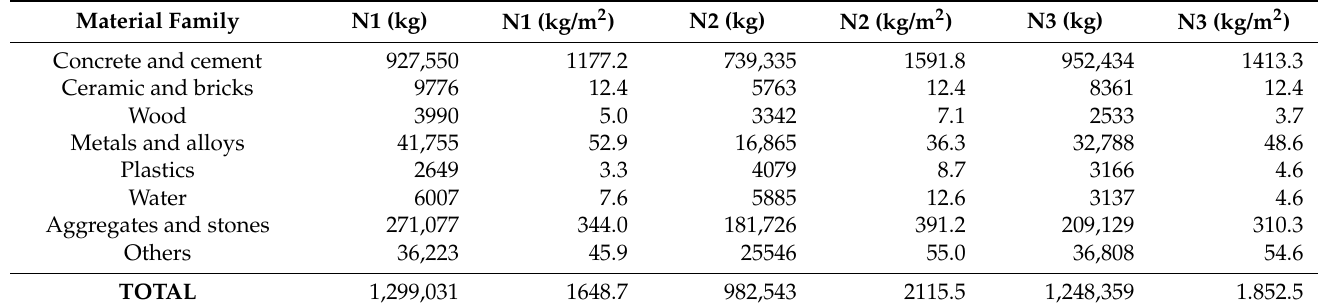
Table 5. Weight of construction materials consumed in the case studies grouped by